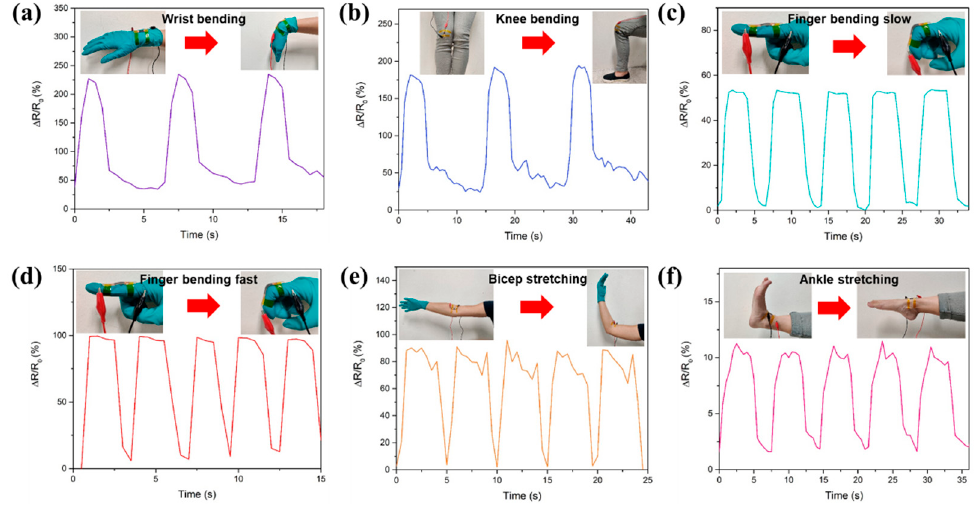
Figure 6. Application of the sensor in monitoring human body movement. ( a ) wrist bending ( b ) knee bending ( c ) finger bending at a slow pace ( d ) finger bending at a fast pace ( e ) bicep stretching ( f ) ankle stretching.